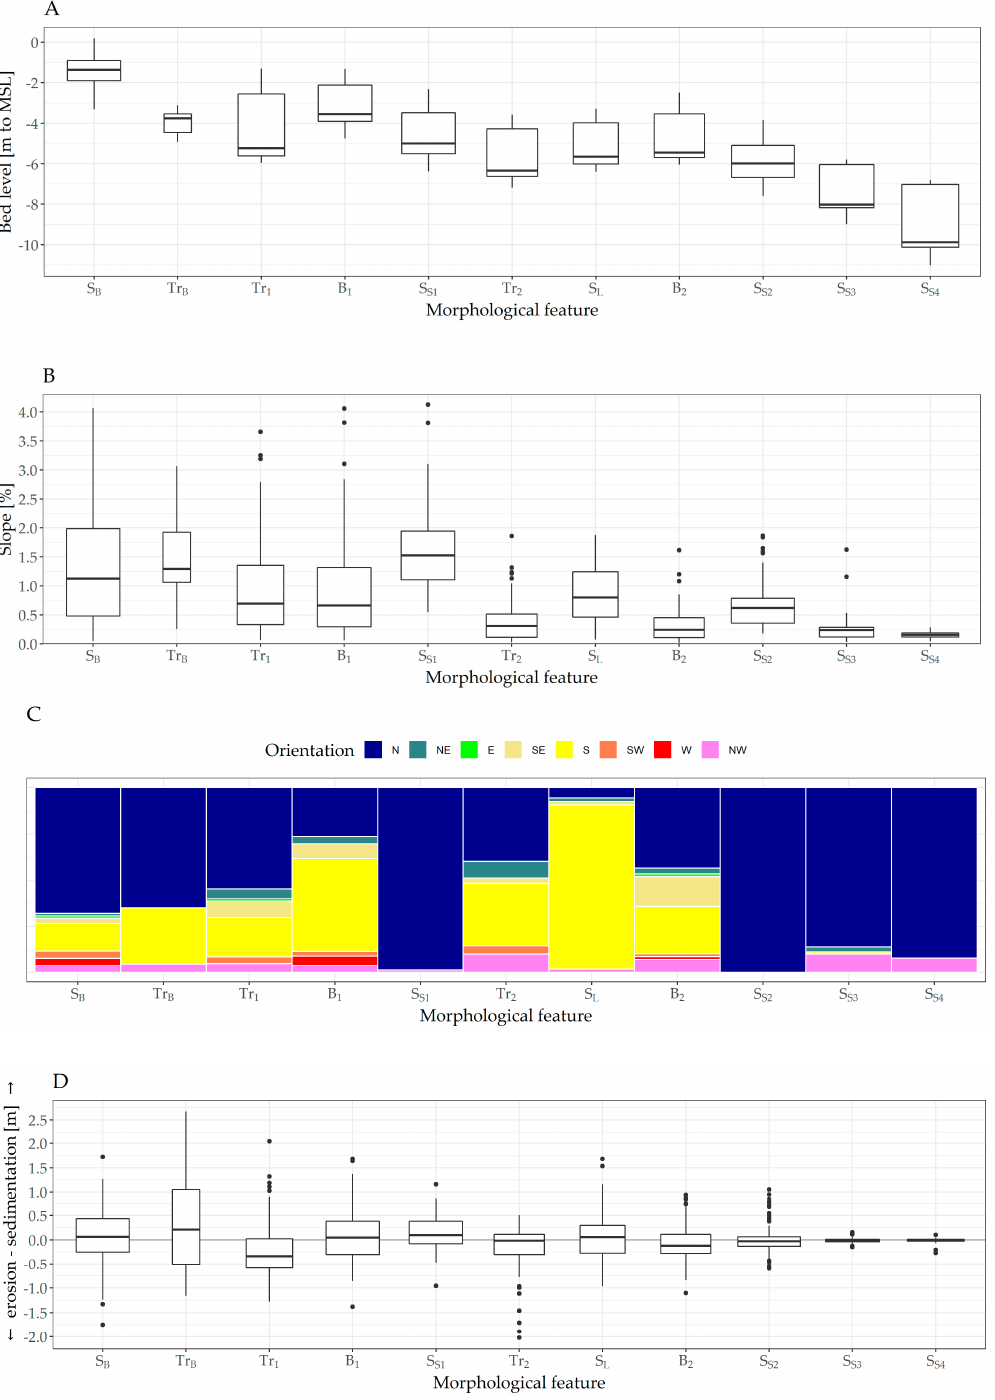
Figure 3. Boxplots of the morphometric properties of the morphological features. ( A ) Bed level in meters to MSL. ( B ) Bed slope in percentage rise. ( C ) Aspect, the slope orientation. ( D ) Net annual sedimentation-erosion in meters. Note that the distance between the morphological features on the x as is not to scale.